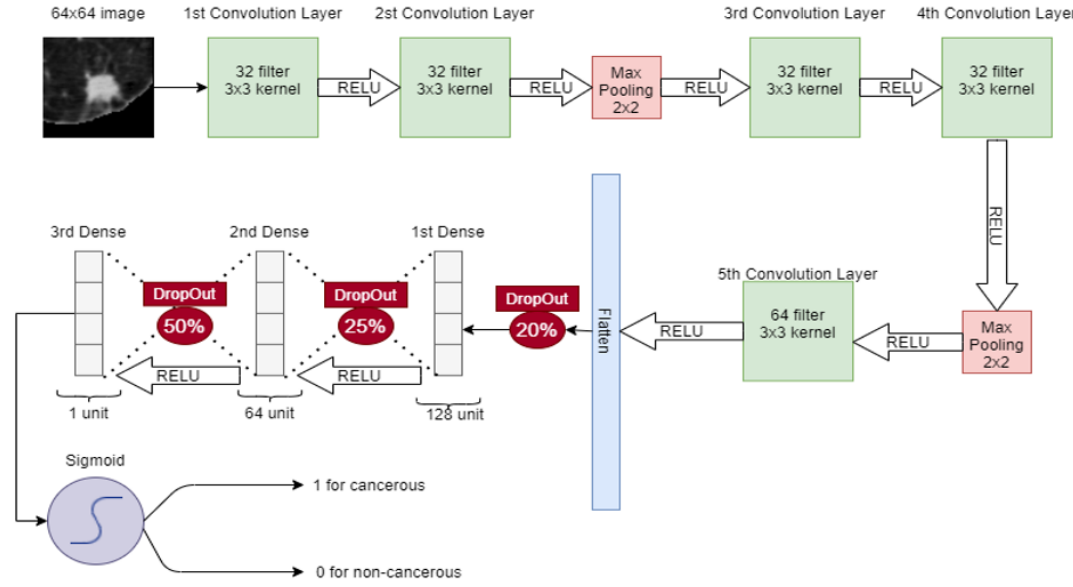
Figure 5. Proposed CNN for classification of nodules (Cancerous-1, Non-Cancerous-0).